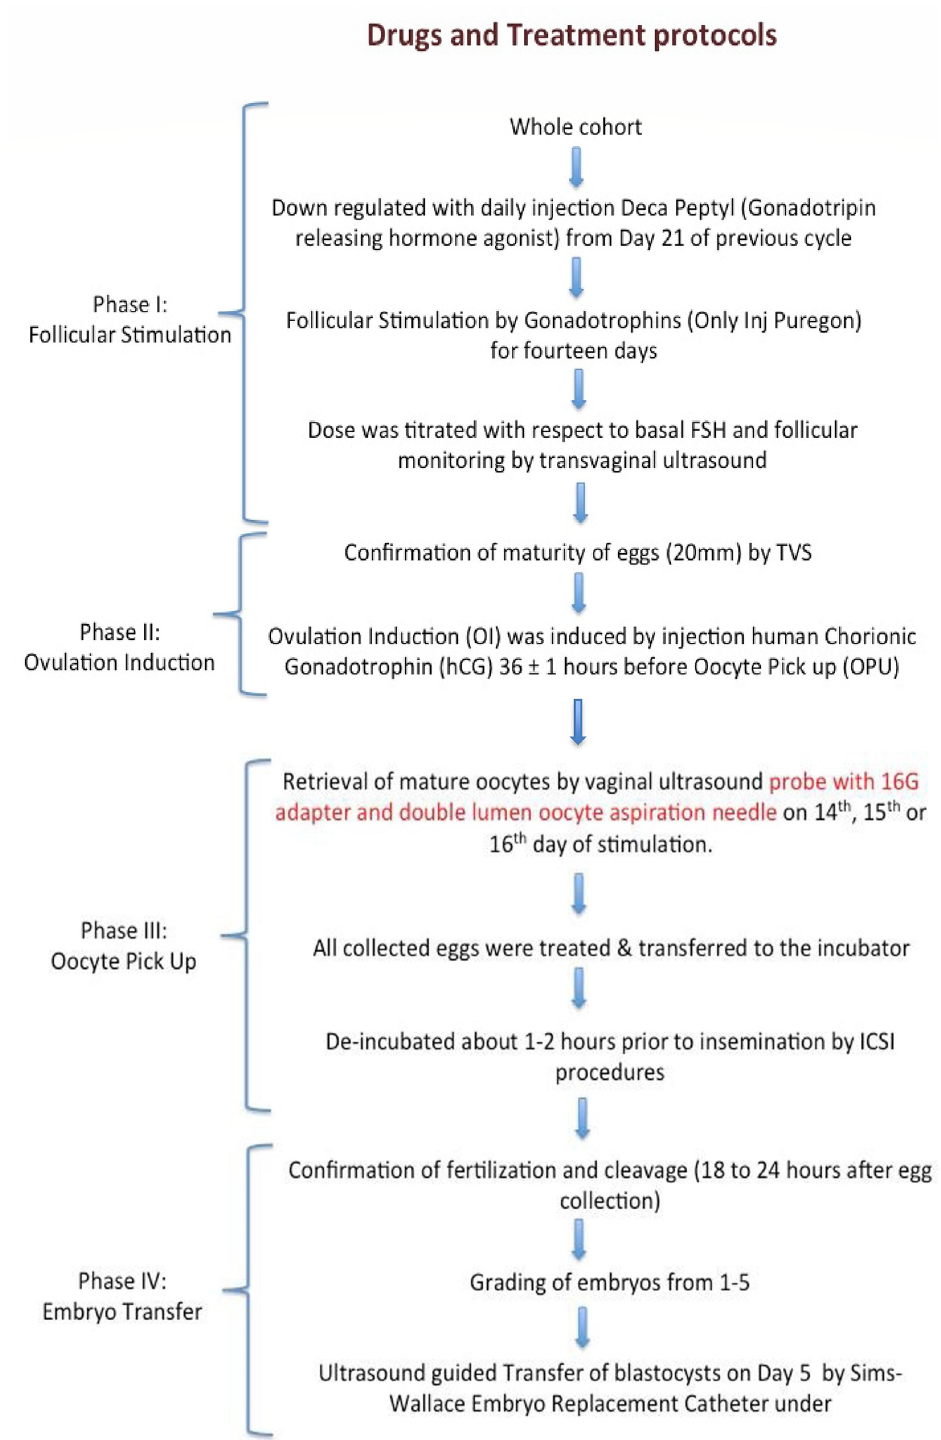
Fig 1. Flow chart of the treatment protocol during the study period. Stage 1: Follicular stimulation (FS) (n = 50). Down-regulation was followed by controlled ovarian stimulation (COS) by gonadotrophin injections (Only Inj Puregon) for fourteen days. The dose was titrated with respect to basal FSH and follicular monitoring by Transvaginal Ultrasound (TVS). Out of the 50 females, 44 females reached the ovarian induction stage (stage 2). Cycle of 4 females was cancelled due to inadequate response to stimulation, whereas two did not opt to continue the treatment. Stage 2: